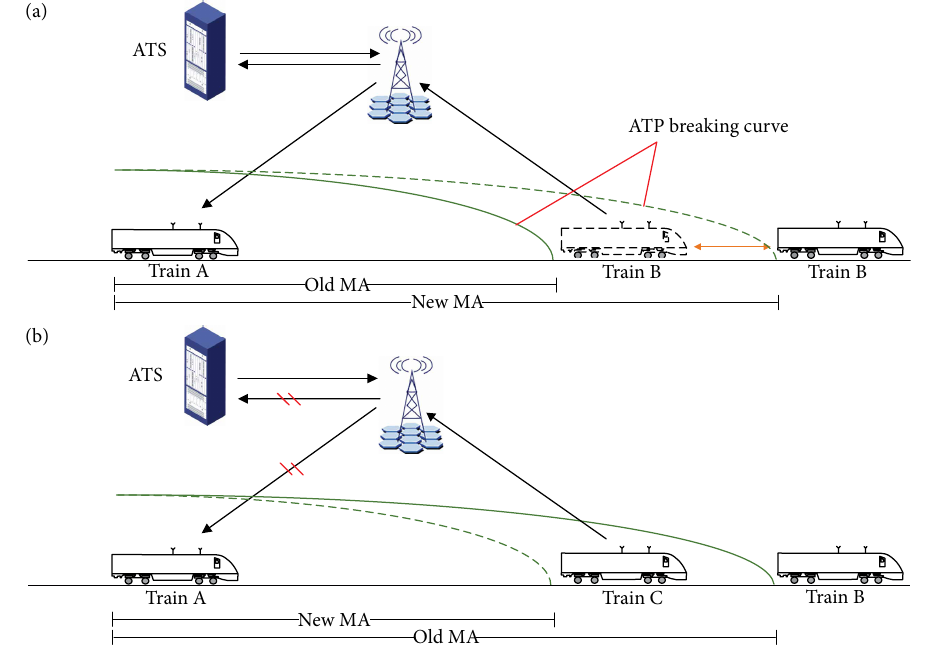
Figure 2: The impacts of communication interruption on CBTC